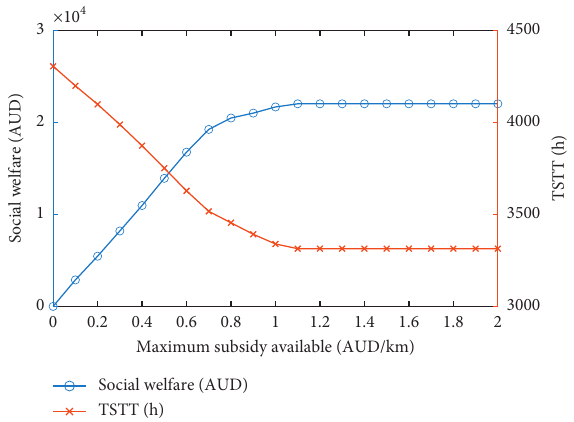
Figure 3: Social welfare and TSTT as functions of